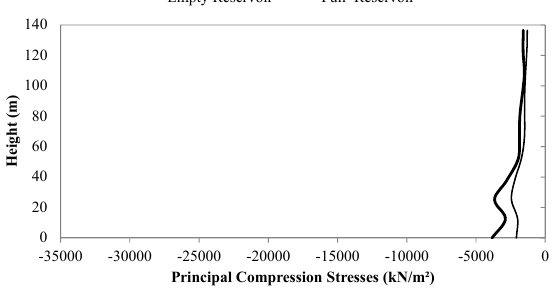
Fig. 21. The maximum principle stress components in III-III section.